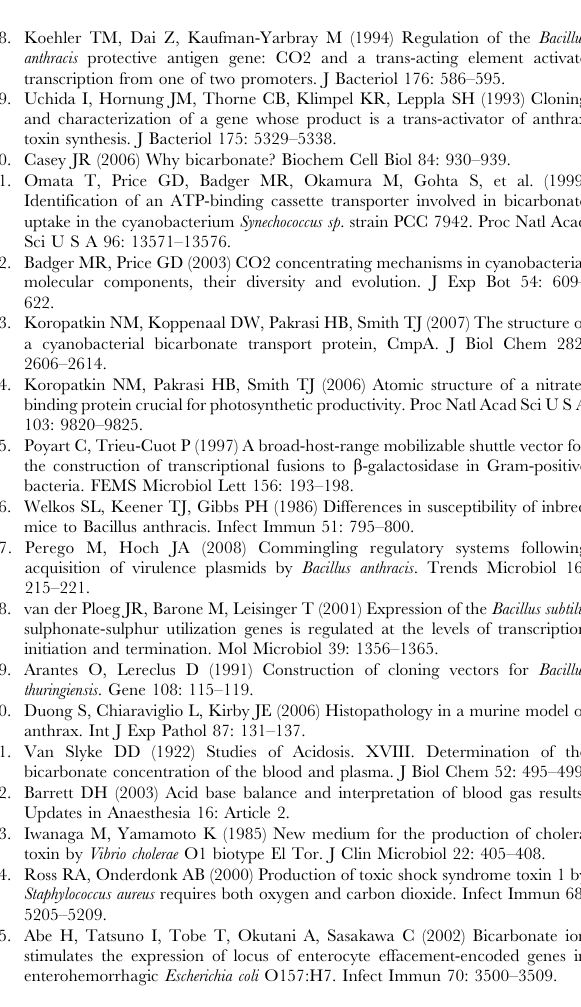
Table S1 Oligonucleotide primers used in this